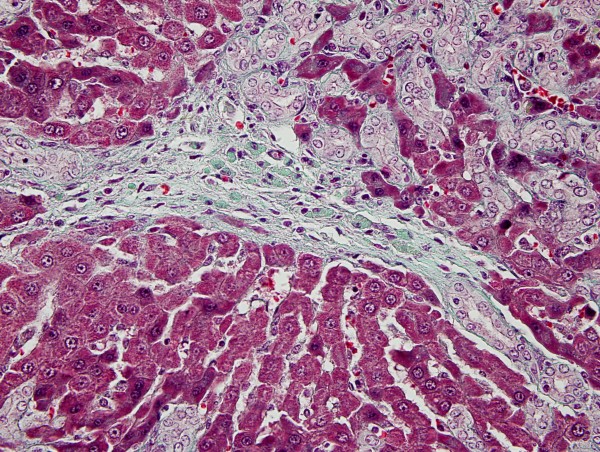
Tricrome stained section showed portal-portal fibrosis (×40). Green areas were fibrotic and red areas were normal.